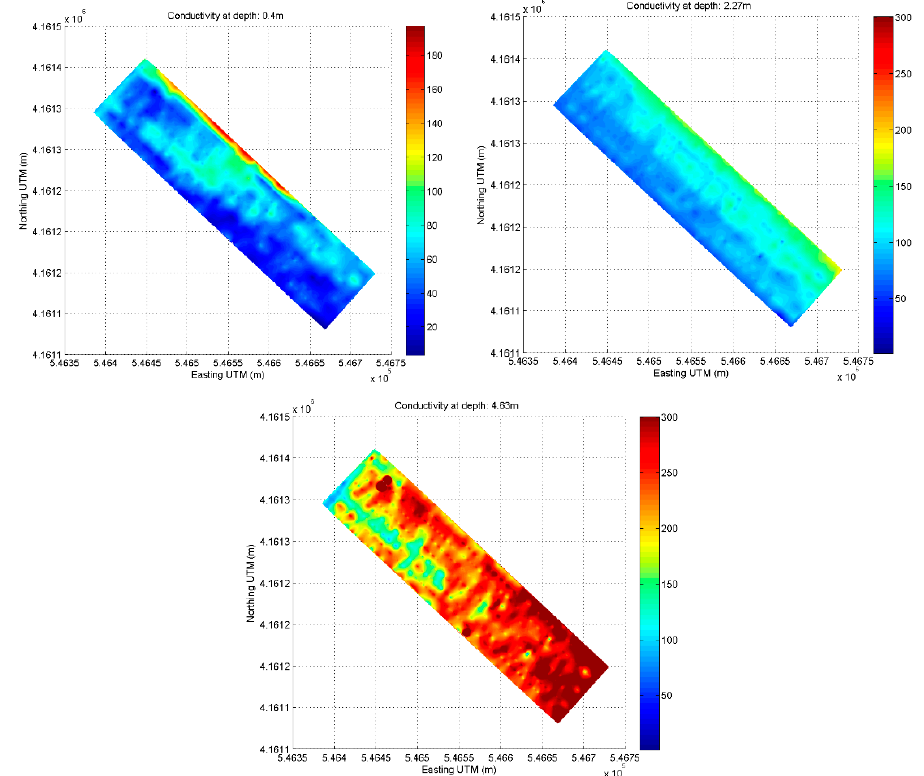
Figure 6. Contour map of the electric conductivity in three different slices at depths of 0.4 m, 2.3 m, and 4.6 m.